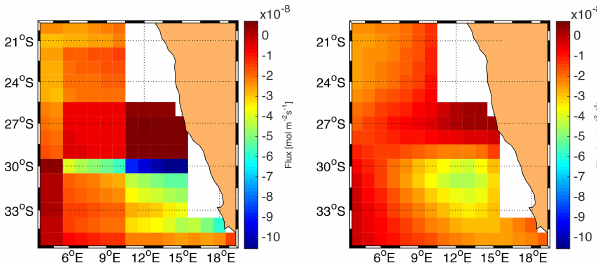
Figure 1. Estimated fluxes from CarbonTracker data. Shown are the results on the Benguela upwelling system on 23 March 2006. Left are the CarbonTracker fluxes, right are our results.